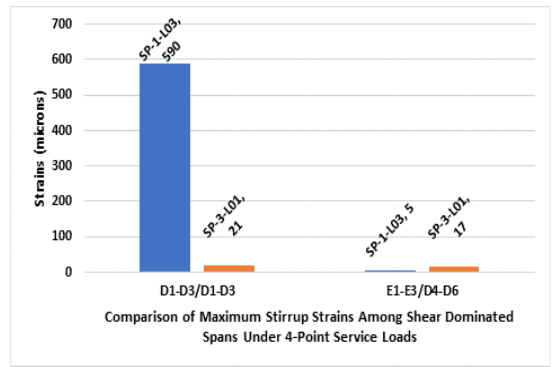
Figure 35. Comparison of maximum stirrup strains recorded for loading setup SP-1-L03 and SP-3-L01 under four-point service loads.